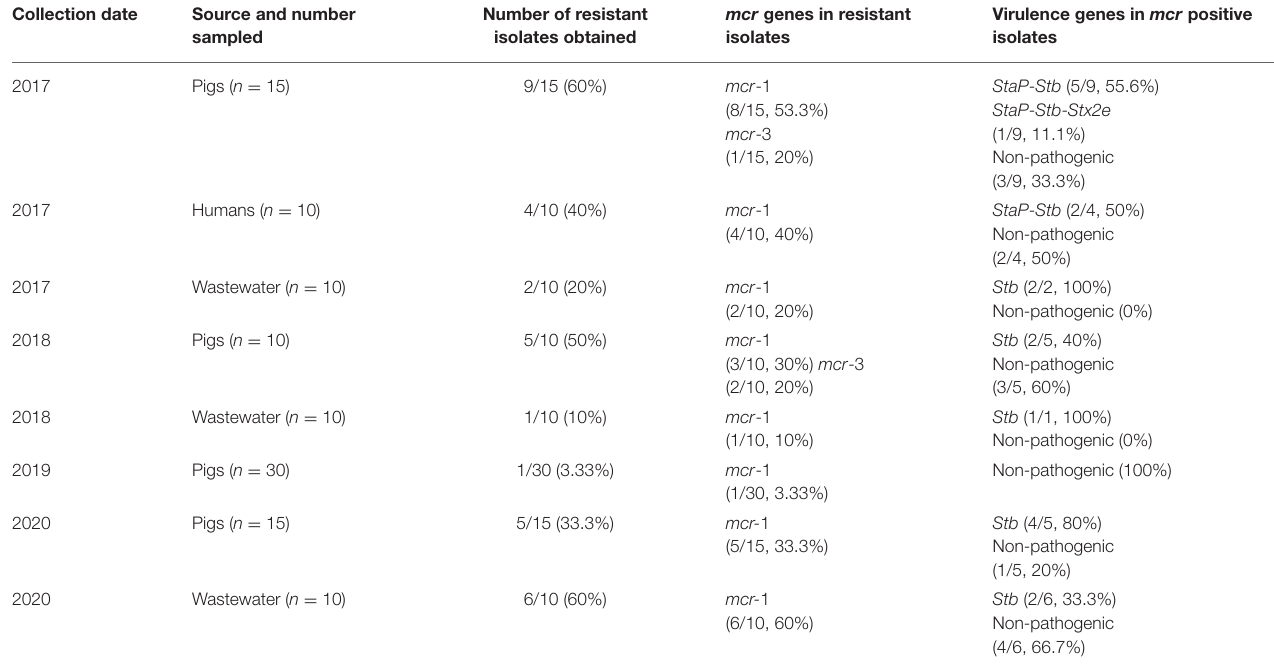
TABLE 2 | Characterization of 33 colistin-resistant mcr positive E. coli isolates from different years and